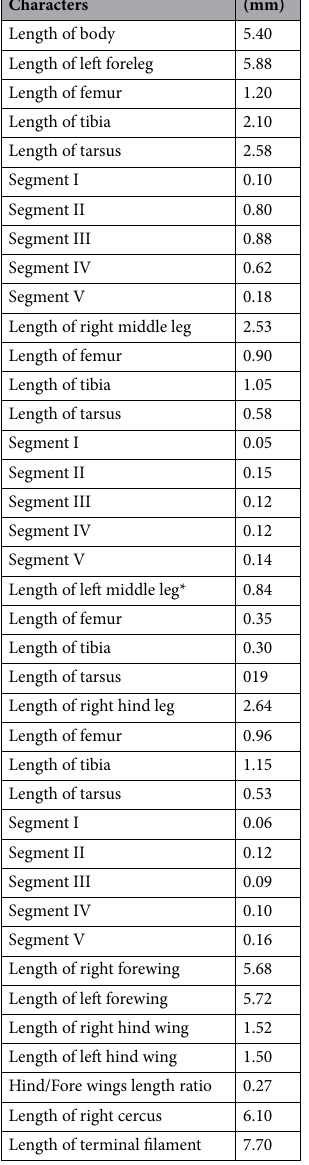
Table 1. Measurements of the holotype of Calliarcys antiquus sp. nov. (male imago; BB 2515; SMNS coll.). *Malformed leg as a result of nymphal leg